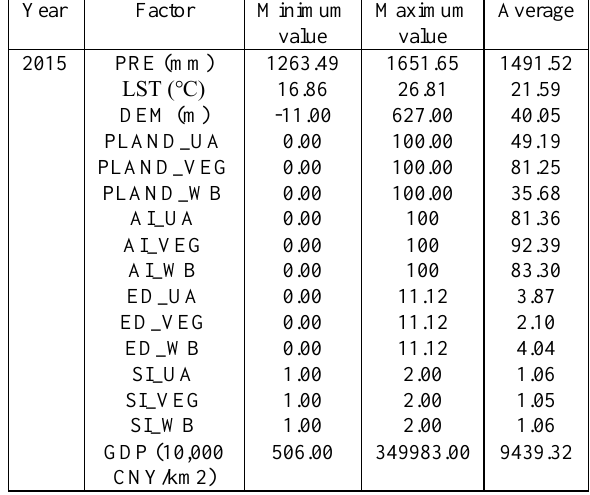
Table 7. Details of impact factors in 2015.